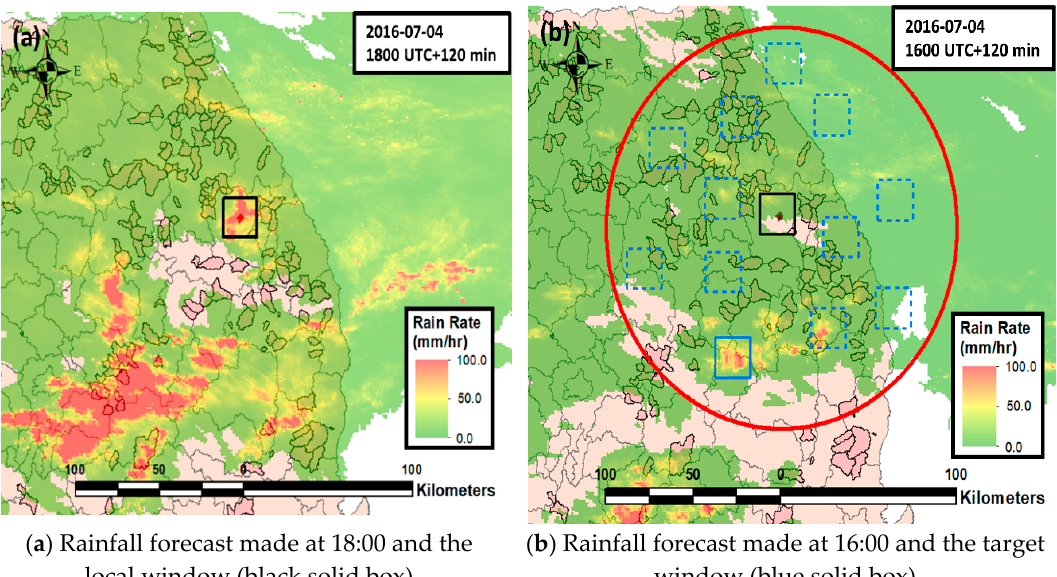
Figure 5. Local window (black solid box in ( a )) made for the Ducsanggi Valley over the two-hour rainfall forecasts made at 18:00 4 July 2016 and the resulting target window (blue solid box in ( b )) determined by applying the backward tracking method over the two-hour rainfall forecasts made at 16:00 at the same day.